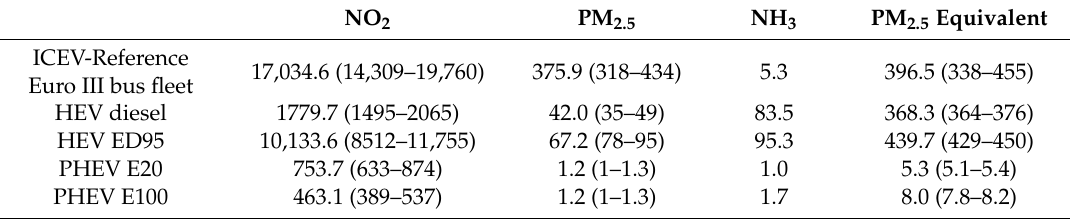
Table 9. Criteria pollutants for the Ecuadorian bus fleet in ton / year, with uncertainty.